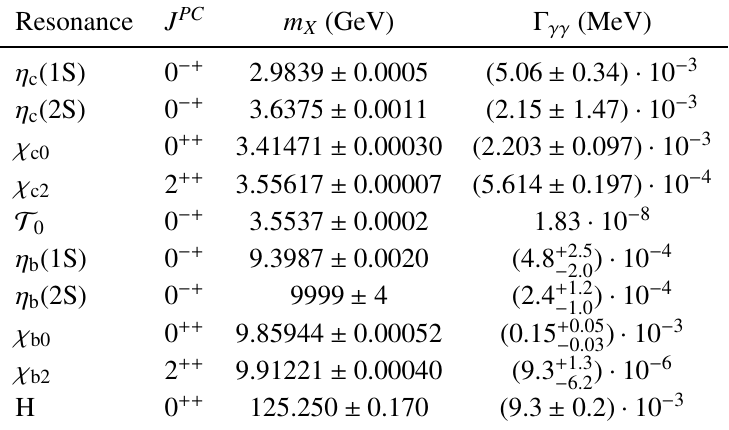
Table 4 . List of all known C -even resonances above m X (cid:25) 3 GeV that can be produced via two-photon fusion. For each particle, we quote its J PC quantum numbers, mass m X , and diphoton partial width (cid:0) (cid:13)(cid:13) from measurements [117] or theoretical predictions (for (cid:17) b (2S), (cid:31) b0 ; (cid:31) b2 , T 0 , and H, see text for